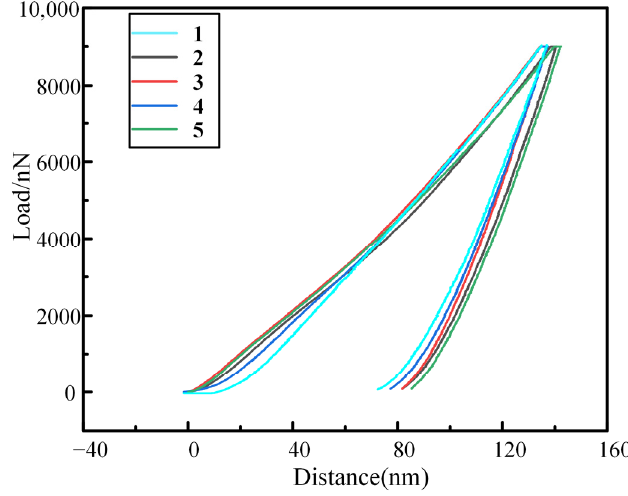
Figure 6. Five times loading-unloading cycle curve of M50 bearing steel in Nanoindentation test. Through curve fitting and analysis, nanoindentation hardness values measured by each loading-unloading curve are obtained, which are 10.85 GPa, 10.14 GPa, 10.41 GPa, 10.62 GPa, and 9.98 GPa, respectively. The results are plotted in Figure 7.